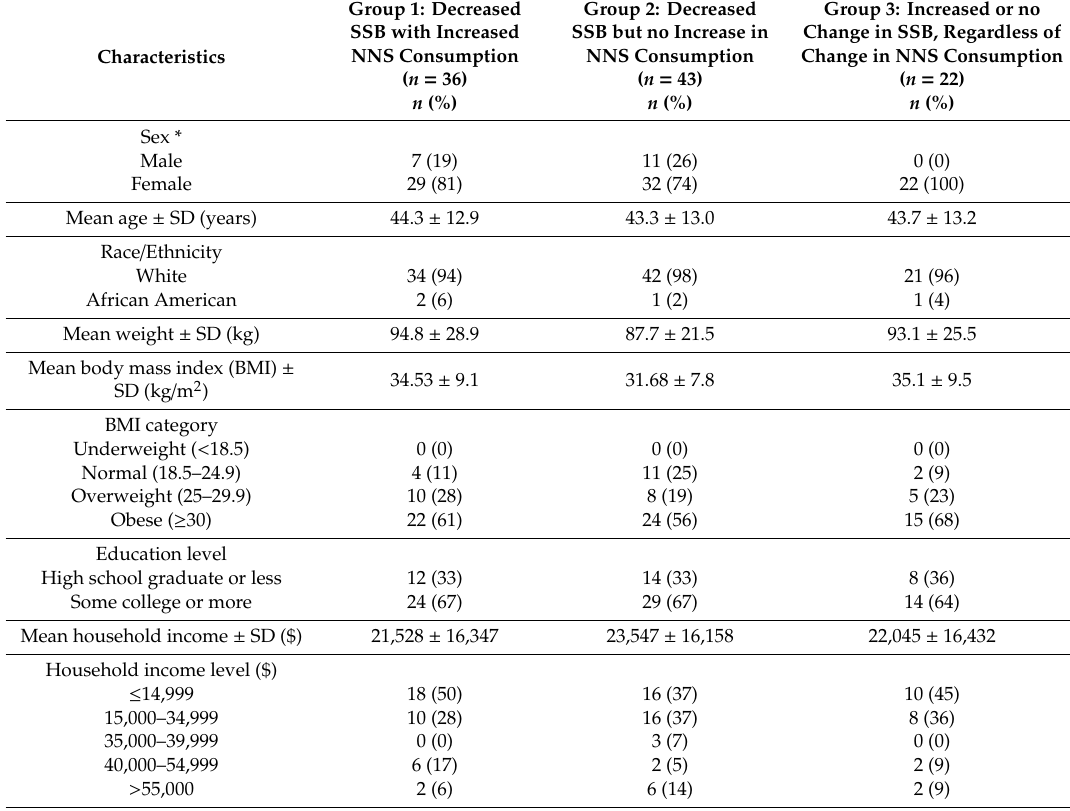
Table 4. Demographic characteristics of SSB-NNS consumption change groups from SIPsmartER participants ( n = 101) at 6 months a